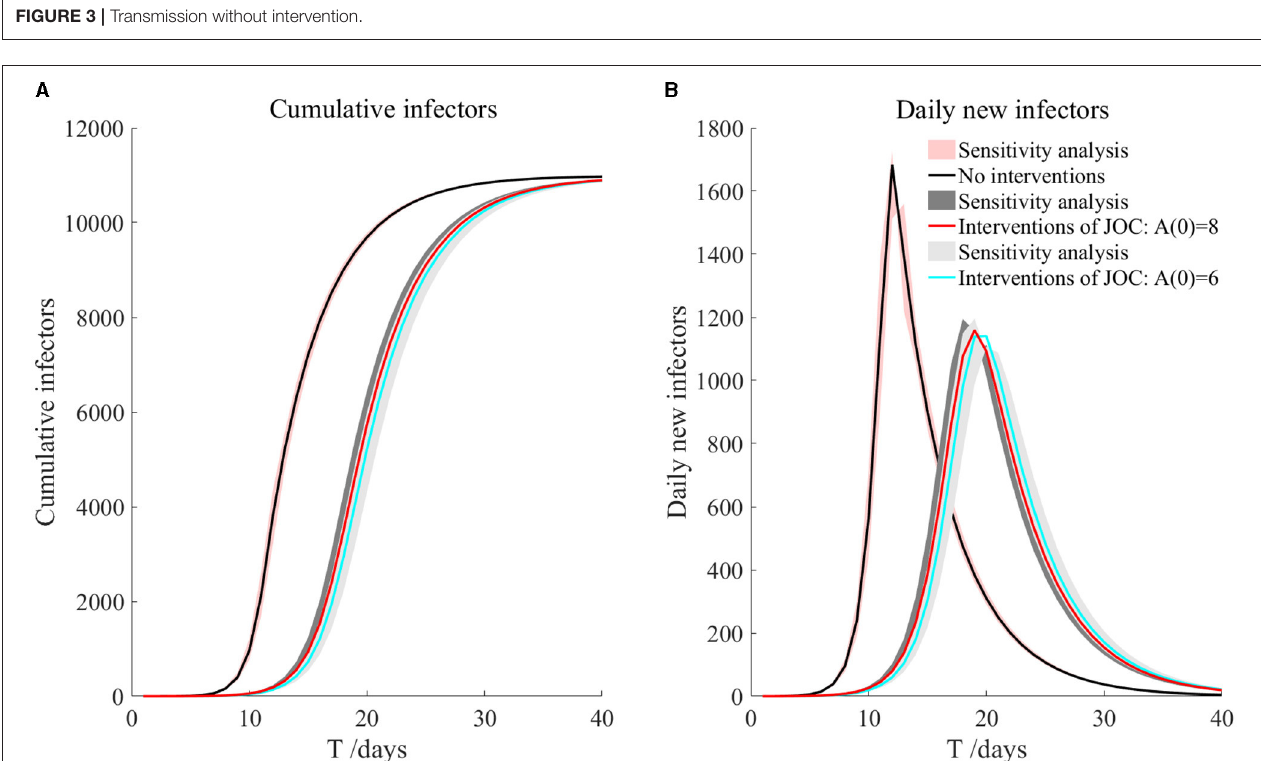
FIGURE 4 | The transmission after JOC